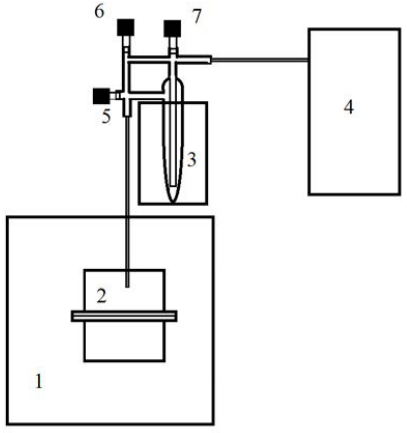
Figure 3. Scheme of an experimental setup for studying the composition of the reaction mixture under static conditions: 1 — thermostat; 2 — reactor; 3 — ampoule bubbler with SiHCl 3 ; 4 — chromatograph; 5, 6, and 7 — control valves.